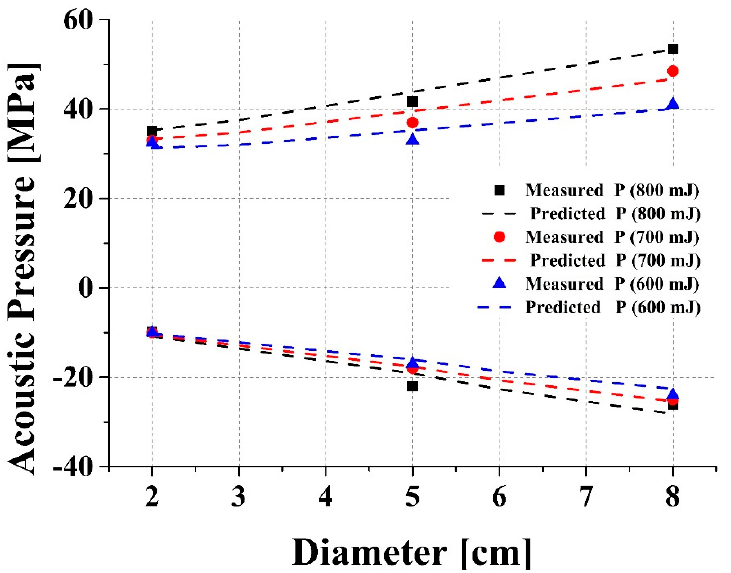
Figure 5. Scatter graph of predicted and experimental (measured) values of the CNT-PDMS composite transducer for different diameters. The dotted lines correspond to the predicted values, while the marks represent the measured values, indicating an agreement between them. This prediction was made at the energy levels of 600 mJ/pulse, 700 mJ/pulse, and 800 mJ/pulse.